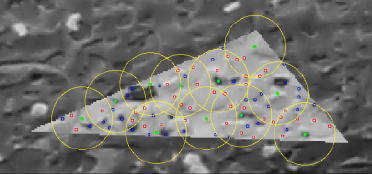
Figure 10. Right: Spatial filter (yellow) keeps only 1 matched point (green) in